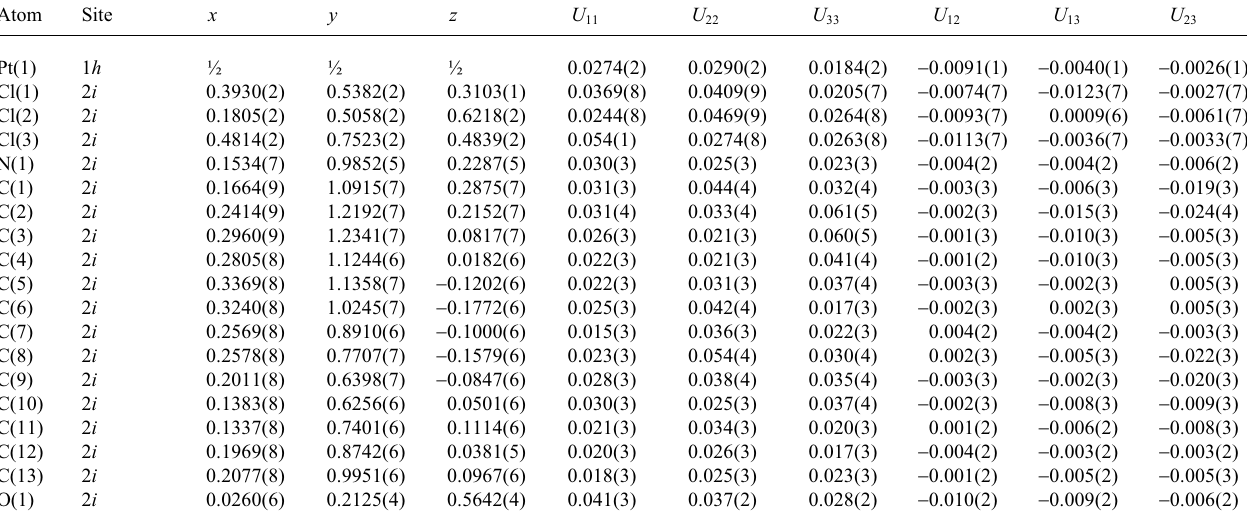
Table 3. Atomic coordinates and displacement parameters (in Å 2